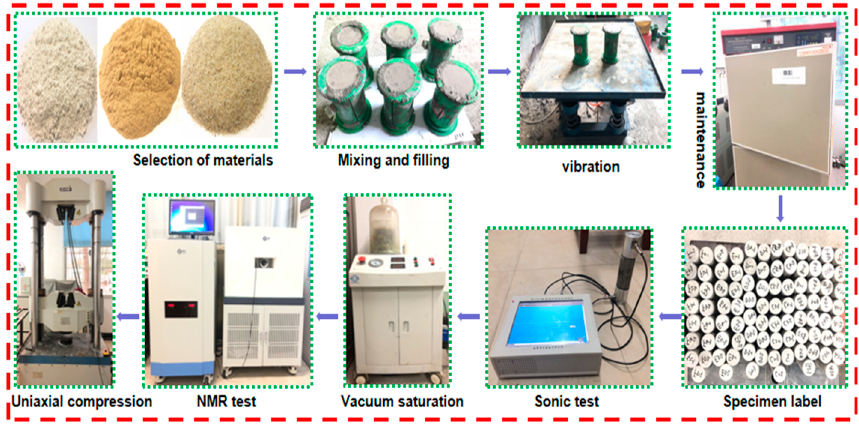
Figure 1. Intuitive presentation of experimental steps.